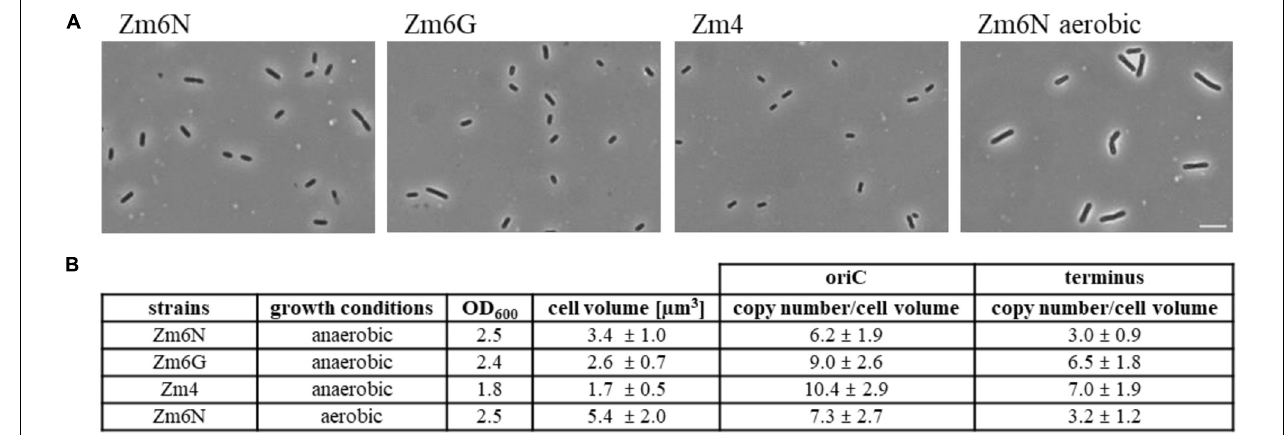
FIGURE 6 | Determination of genome copy numbers per µ m 3 cell volume. (A) Phase contrast images of anaerobically growing Zm6N, Zm6G, and Zm4, and aerobically growing Zm6N cells. Scale bar; 7.85 µ m. (B) A table of cell volume and genomic copy numbers per cell volume in Zm6N, Zm6G, and Zm4 during anerobic growth, and Zm6N during aerobic growth. Cell length and width were measured and used for calculating approximate cell volume. Sample numbers for cell length and width measurements; N = 110 and 53 for anaerobically growing Zm6N, respectively, N = 120 and 52 for Zm6G, N = 110 and 57 for Zm4, and N = 120 and 56 for aerobically growing